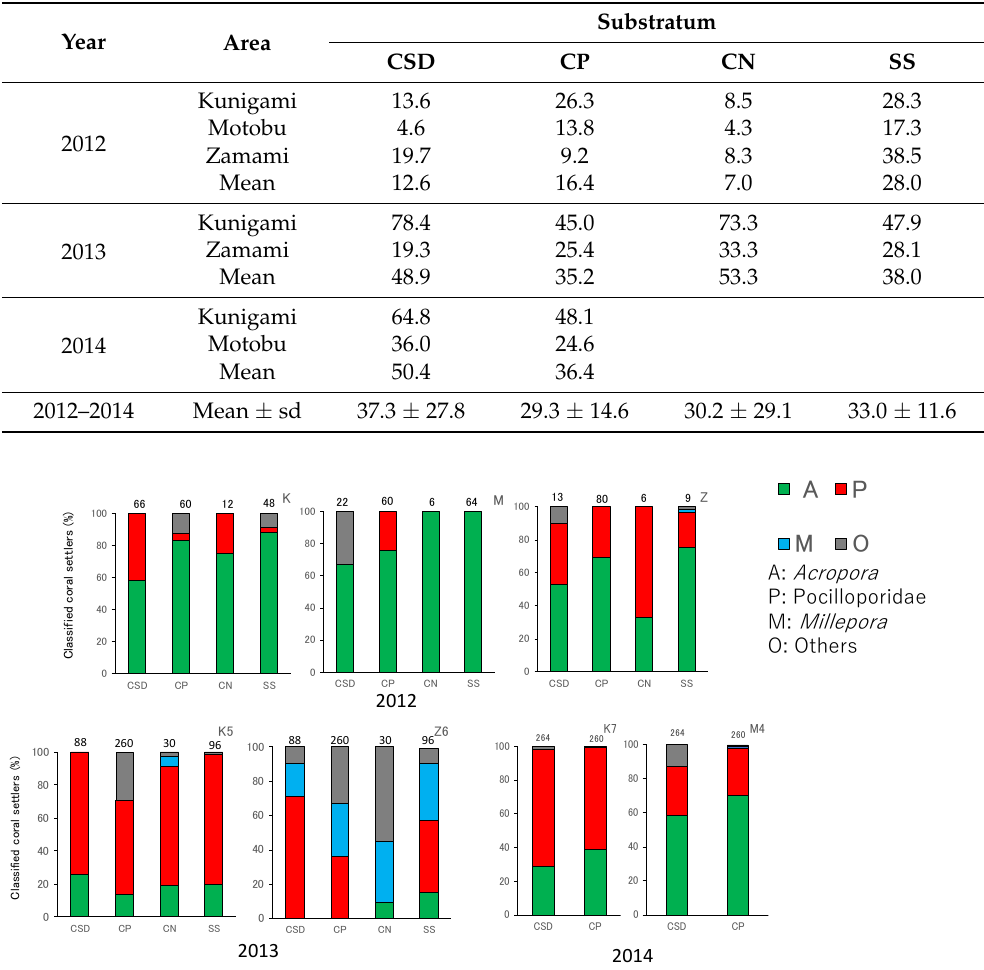
Figure 3. Percentage of coral settlers classified by taxa in the substrata in first sampling. Values in the data bars are the number of analyses.